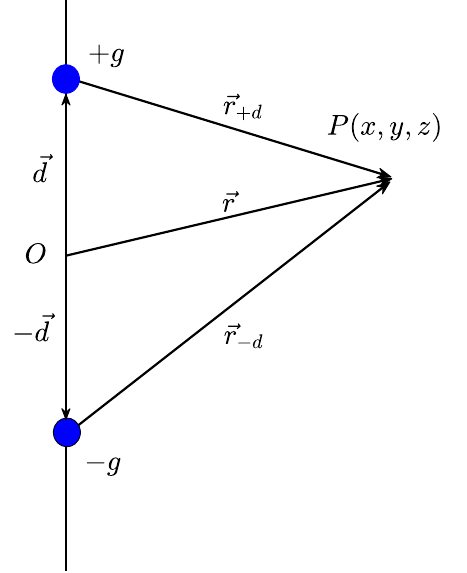
Fig. 1 The magnetic moment configuration discussed in the text